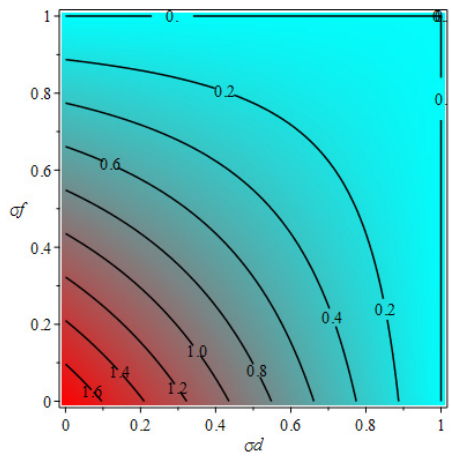
Figure 11. Contour plots of the reproduction number of the model (3), as a function of face mask and social distancing